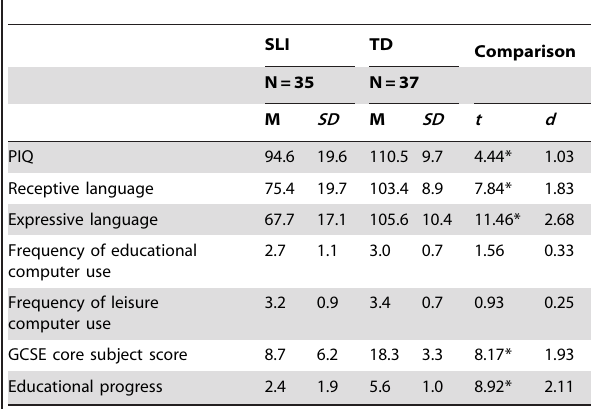
Table 2. Psycholinguistic profiles, frequency of computer use, GCSE core subject score and level of educational progress for young people with SLI and TD peers continuing in post- compulsory